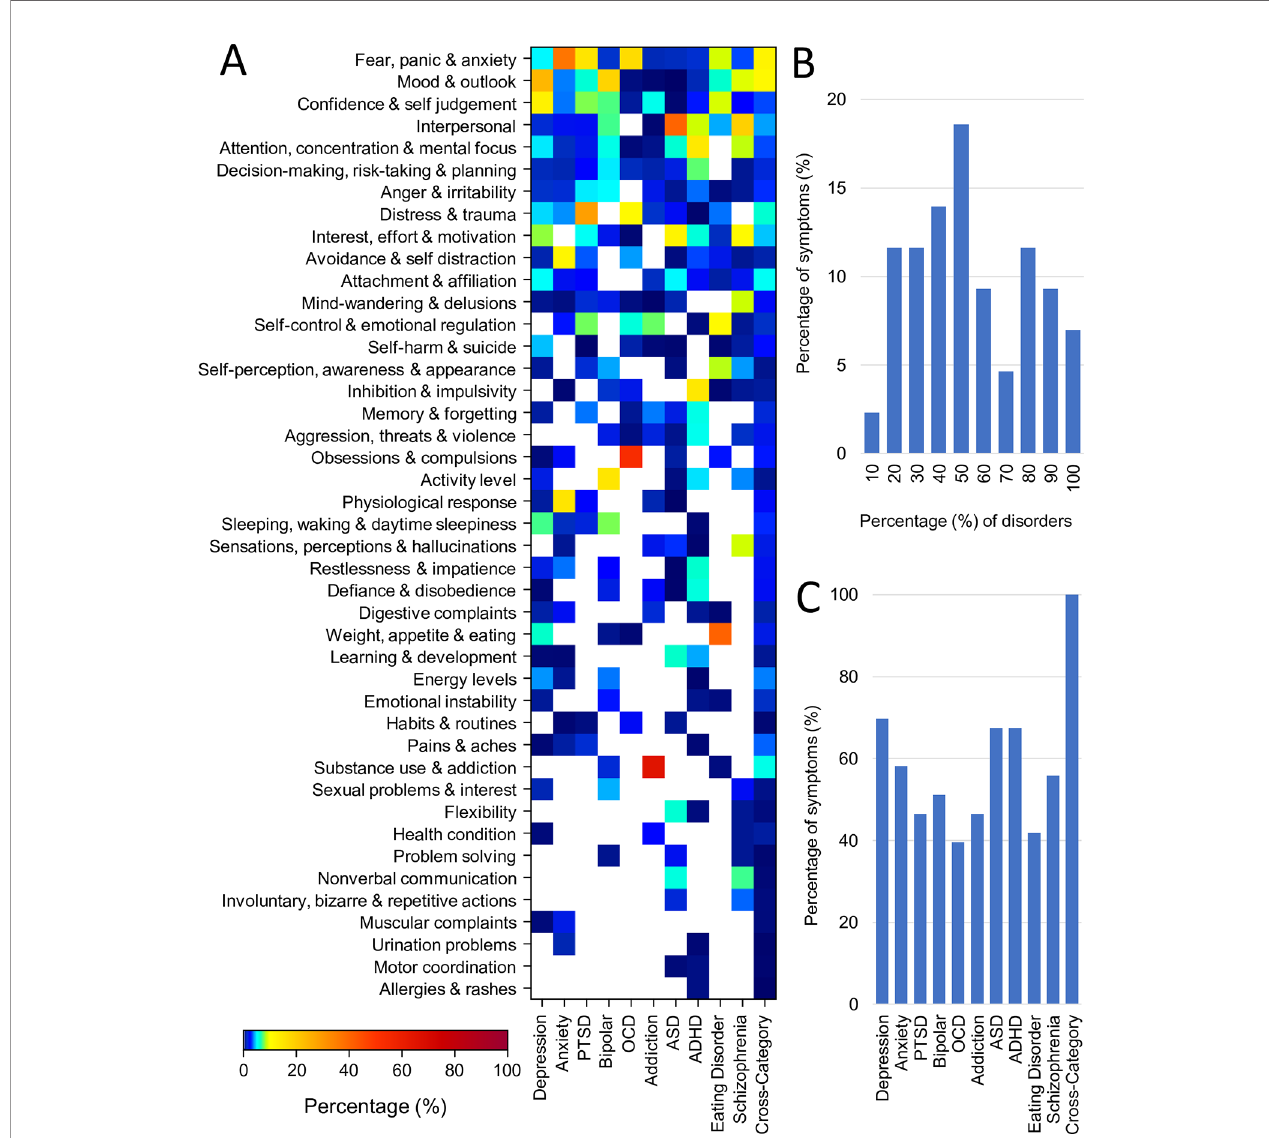
FIGURE 4 | Representation of symptom categories across disorders. (A) Proportion (%) of questions from each of the 43 symptom categories for each disorder (averaged across assessment tools) and for cross disorder tools. (B) Symptom overlap across disorders. First and last bars represent fraction of symptoms belonging to only one disorder and 100% of disorders respectively. (C) Breadth of symptoms assessed for each disorder and for cross-disorder tools. All but one disorder encompassed more than 40% of all